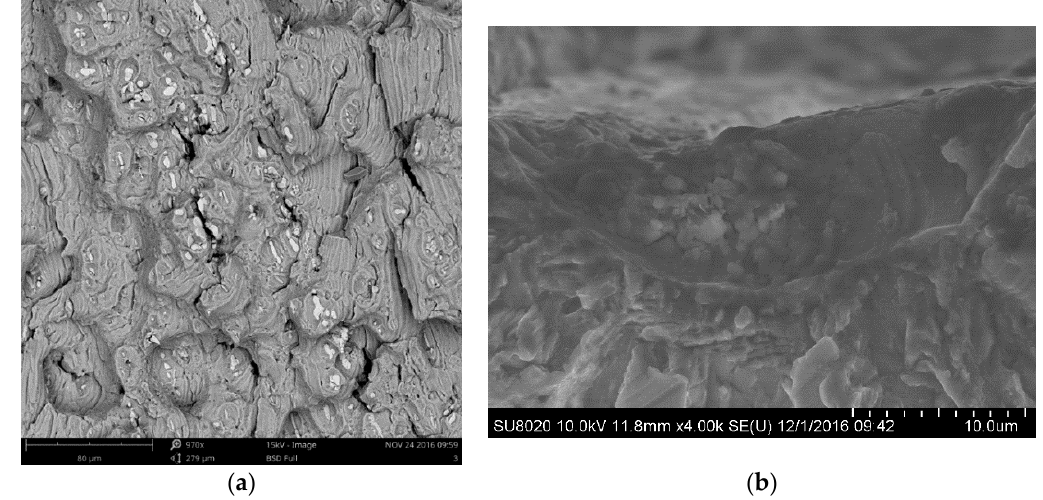
Figure 3. Morphologies of the ( a ) crack propagation area and ( b ) crack initiation site.